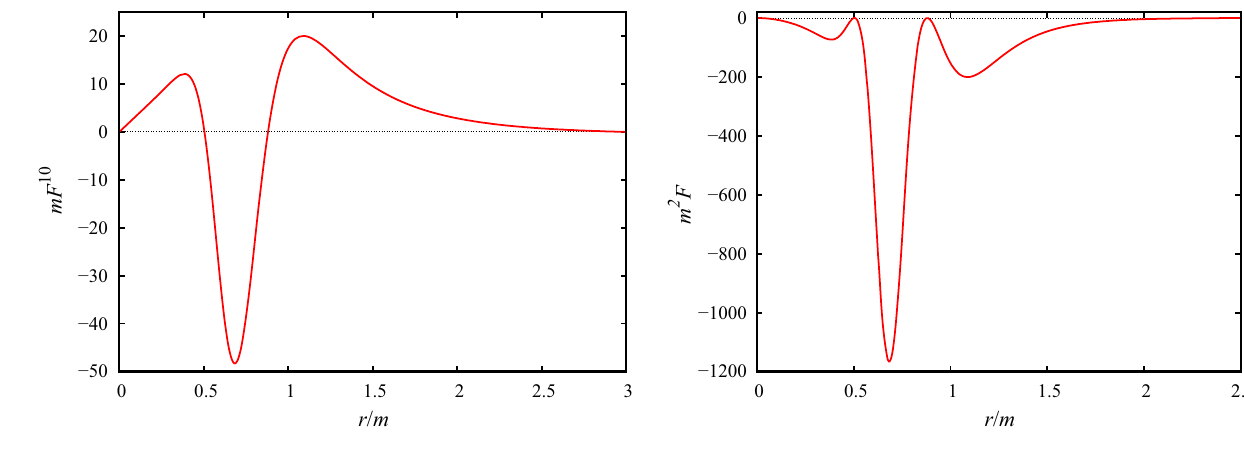
Fig. 5 Electric field and the scalar F in terms of the radial coordinate for mc 1 = 1, κ 2 = 8 π and q = 0 . 7 m